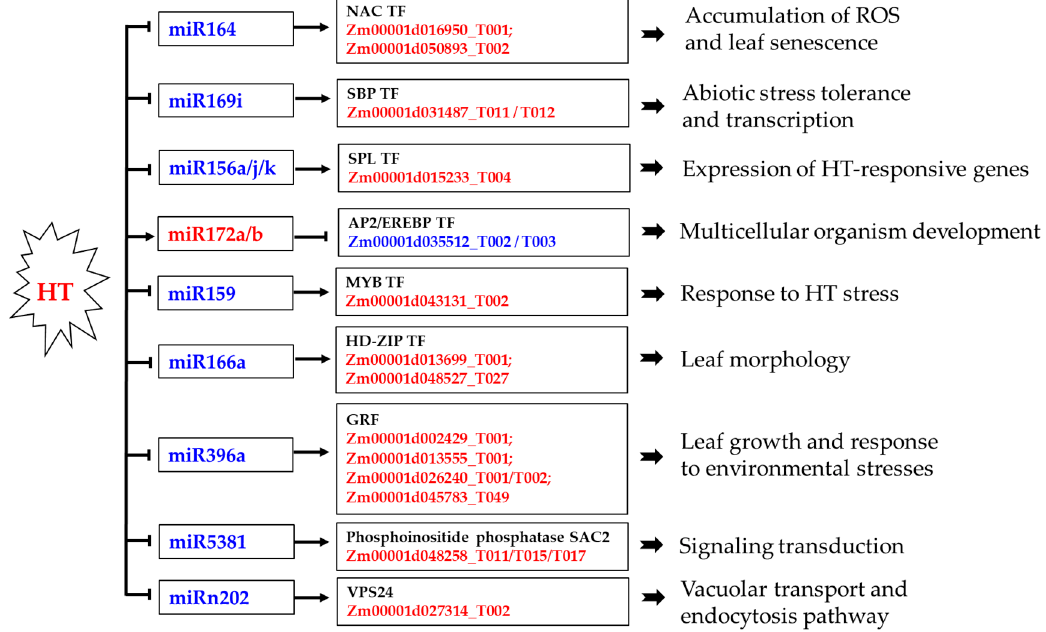
Figure 8. Scheme showing some of the key heat-responsive miRNAs and their targets in maize. The arrows and hammers indicate positive and negative regulation, respectively. The miRNAs/mRNAs in red and blue font were upregulated and downregulated under HT, respectively.